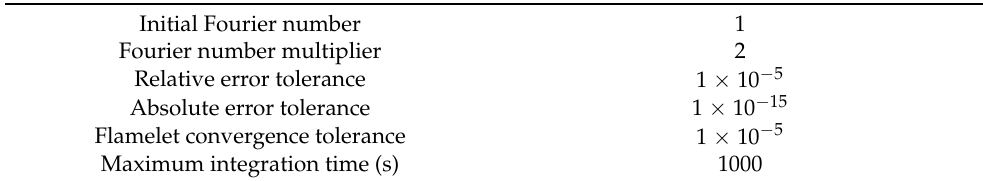
Table 2. Flamelet controls.